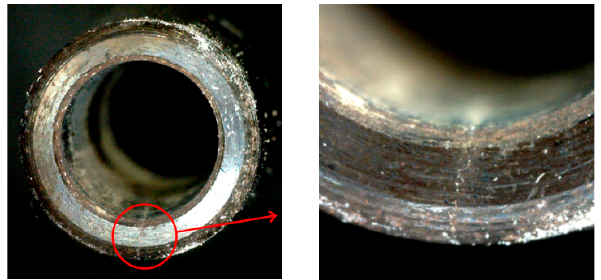
Figure 11. Surface crack of shrink-fit holder.